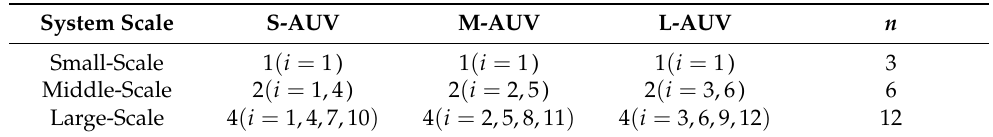
Table 2. Composition of the three scales of the multi-AUVs system.